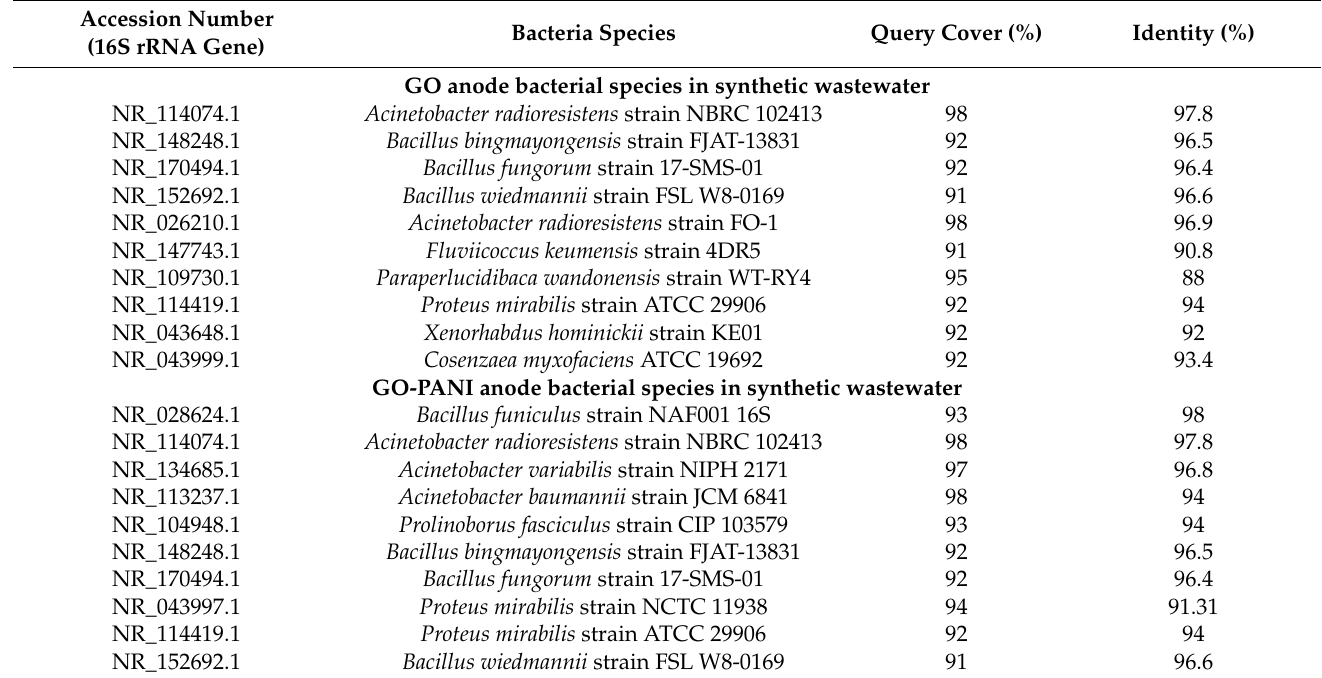
Table 4. List of identified bacterial species from clone libraries of biofilm on surface of self-fabricated